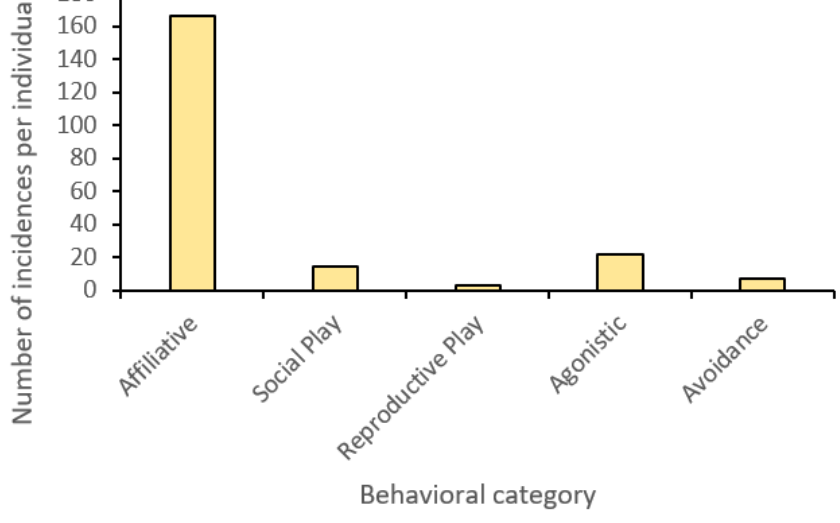
Figure 4. Behavioral category frequency for social interactions between the male (Sirius) and female (Salween) tigers (undirected) at Parc des Félins.